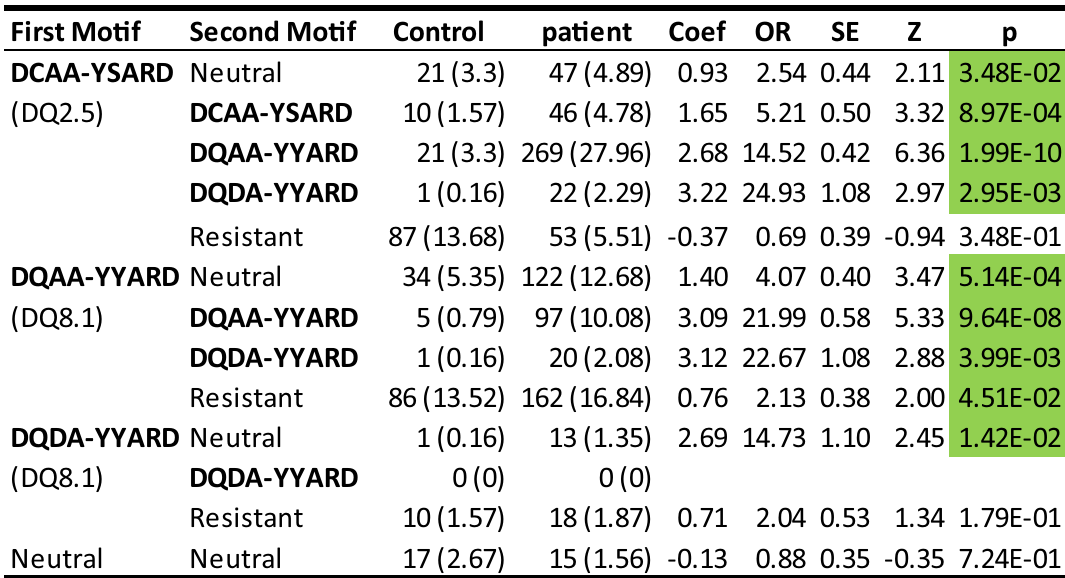
Table 4. Results from the univariate association analysis for three high risk DQ motifs (DQ2.5: DCAA-YSARD, DQ8.1: DQAA-YYARD and DQ8.1: DQDA-YYARD), after accounting for all neutral and resistant motifs. Numbers and frequence percentages of genotype groups are listed for controls and patients, and so are estimated coef (log odds ratio), standard error, Z score, and p-value. The reference genotype is the specific genotype versus all